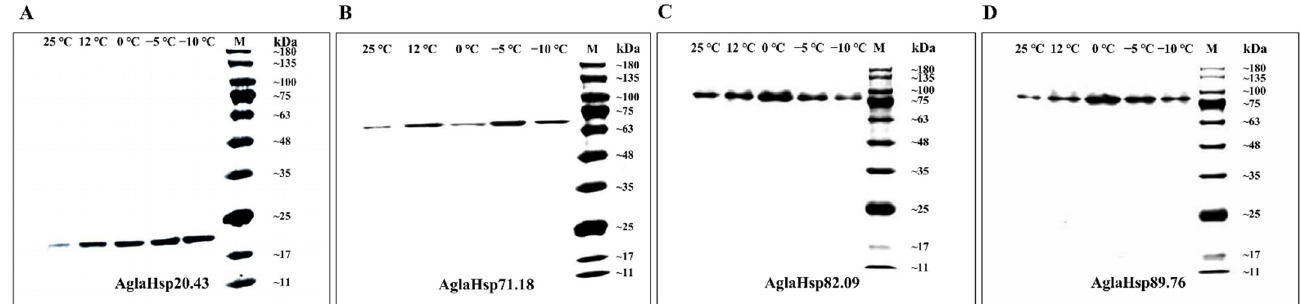
Figure 5. Western blot analysis of AglaHsp20.43 ( A ), AglaHsp71.18 ( B ), AglaHsp82.09 ( C ), and AglaHsp89.76 ( D ) expressions after treatment with different temperatures. Expression levels of the target proteins were estimated according to the band intensities. M: Protein fragment size marker (Protein Ladder 11 ‐ 180 kDa).